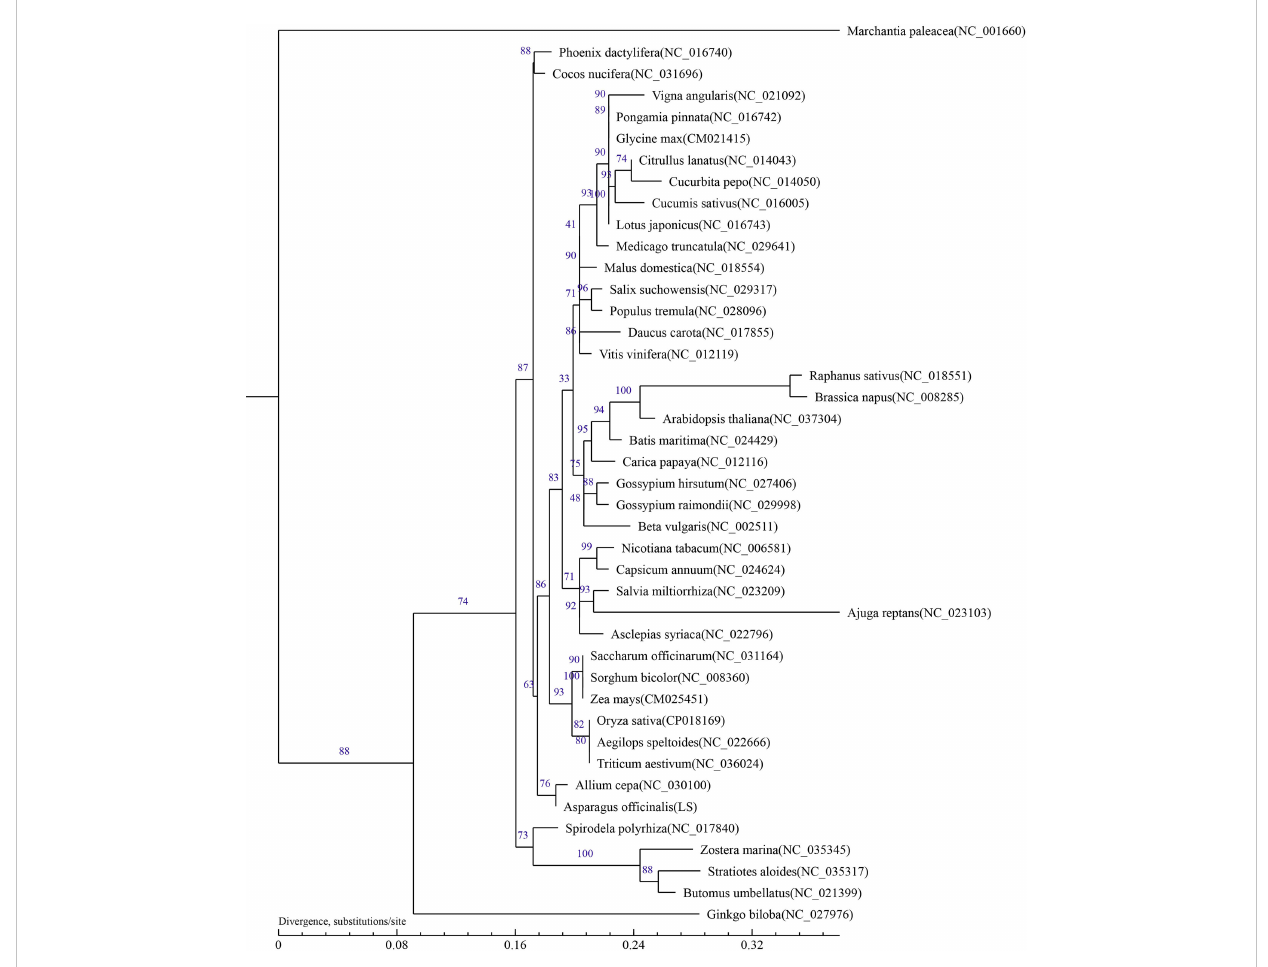
FIGURE 4 Phylogenetic tree inferred based on 23 conserved protein-coding genes of 42 typical plant mitochondrial genomes. Numbers on each node were bootstrap support values. Marchantia paleacea was used as the